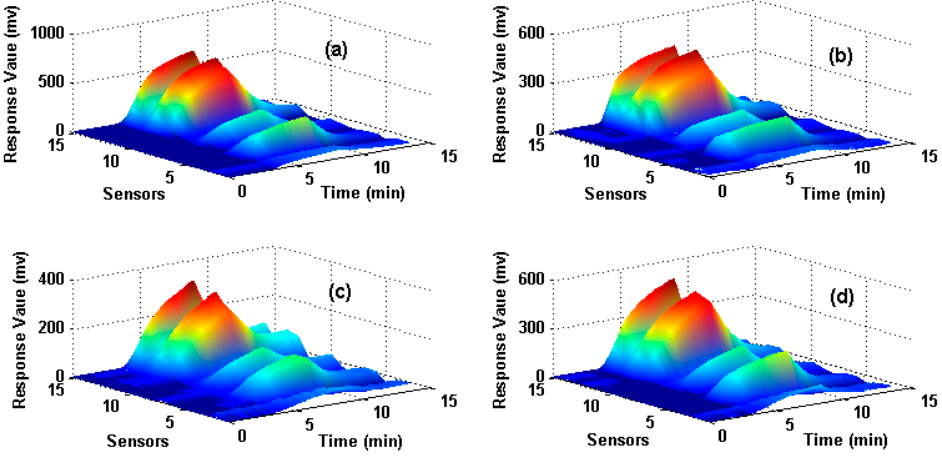
Figure 1. Response process of sensors on four different types of wounds Subfigures ( a – d ) correspond to the uninfected wound, wounds infected by S. aureus , E. coli and P. aeruginosa respectively.